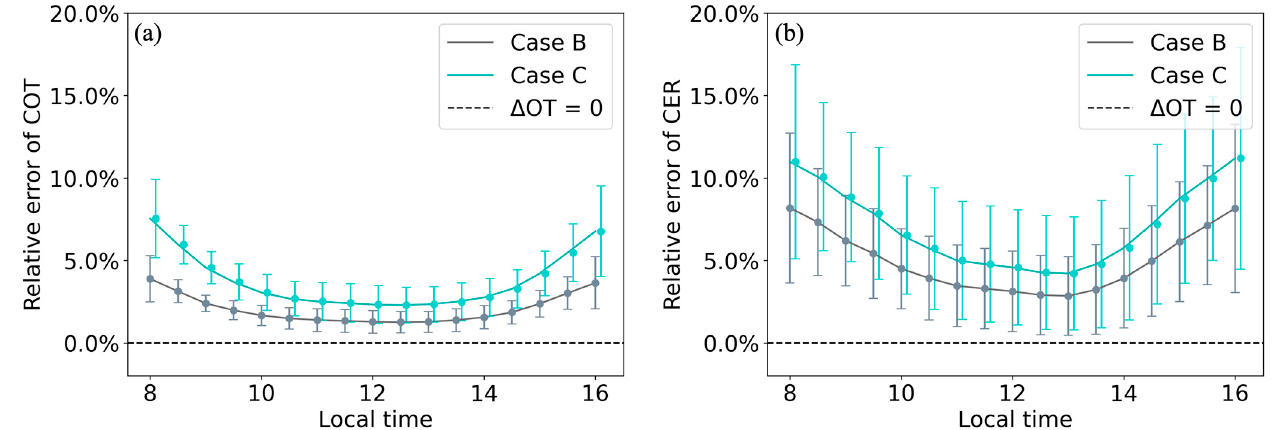
Figure 8. Relative error of ( a ) COT and ( b ) CER in Case B and Case C as a function of LT, based on GOES-17 retrievals for high clouds.